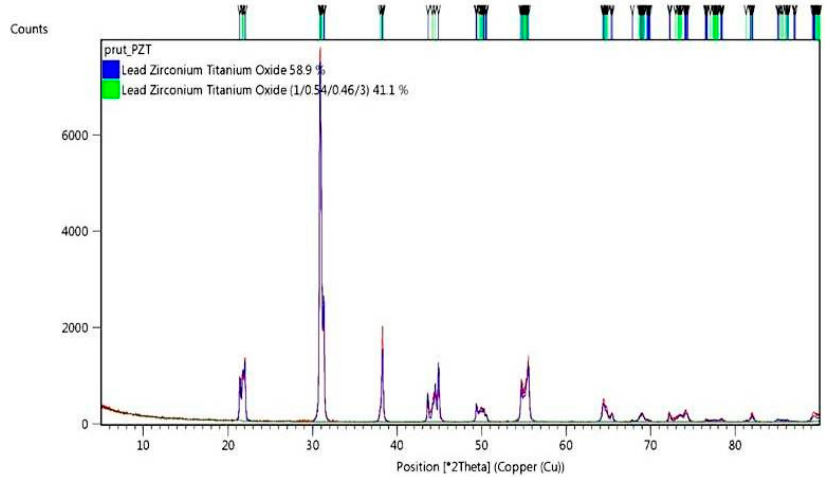
Figure 2. X-ray di ff raction (XRD) pattern of the as-received PZT commercial Figure 2. X-ray diffraction ( XRD) pattern of the as-received PZT commercial powder.